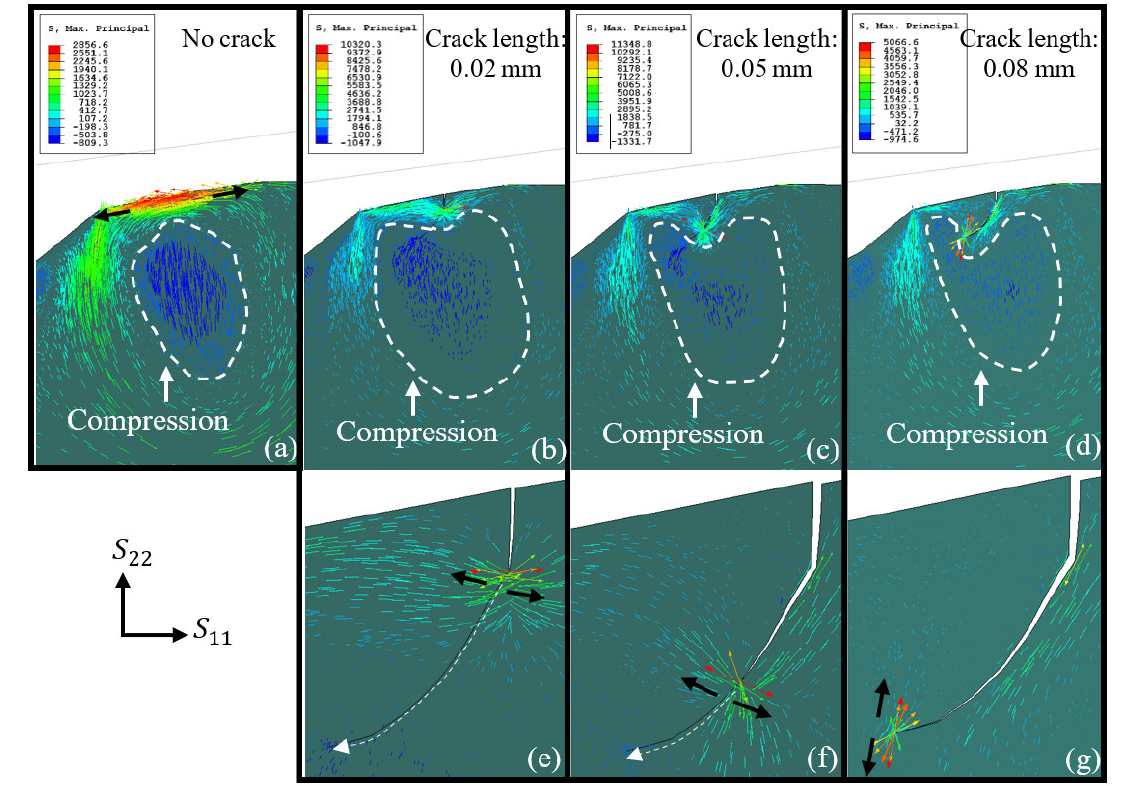
Figure 11. The residual maximum principal stress orientation and magnitude (Mpa) for the unloading stage where ( a ) no crack is implemented, ( b ) crack length of 0.02 mm, ( c ) crack length of 0.05 mm, and ( d ) crack length of 0.07 mm. ( e – g ) are close-ups of the surface cracks in ( b – d ), respectively.